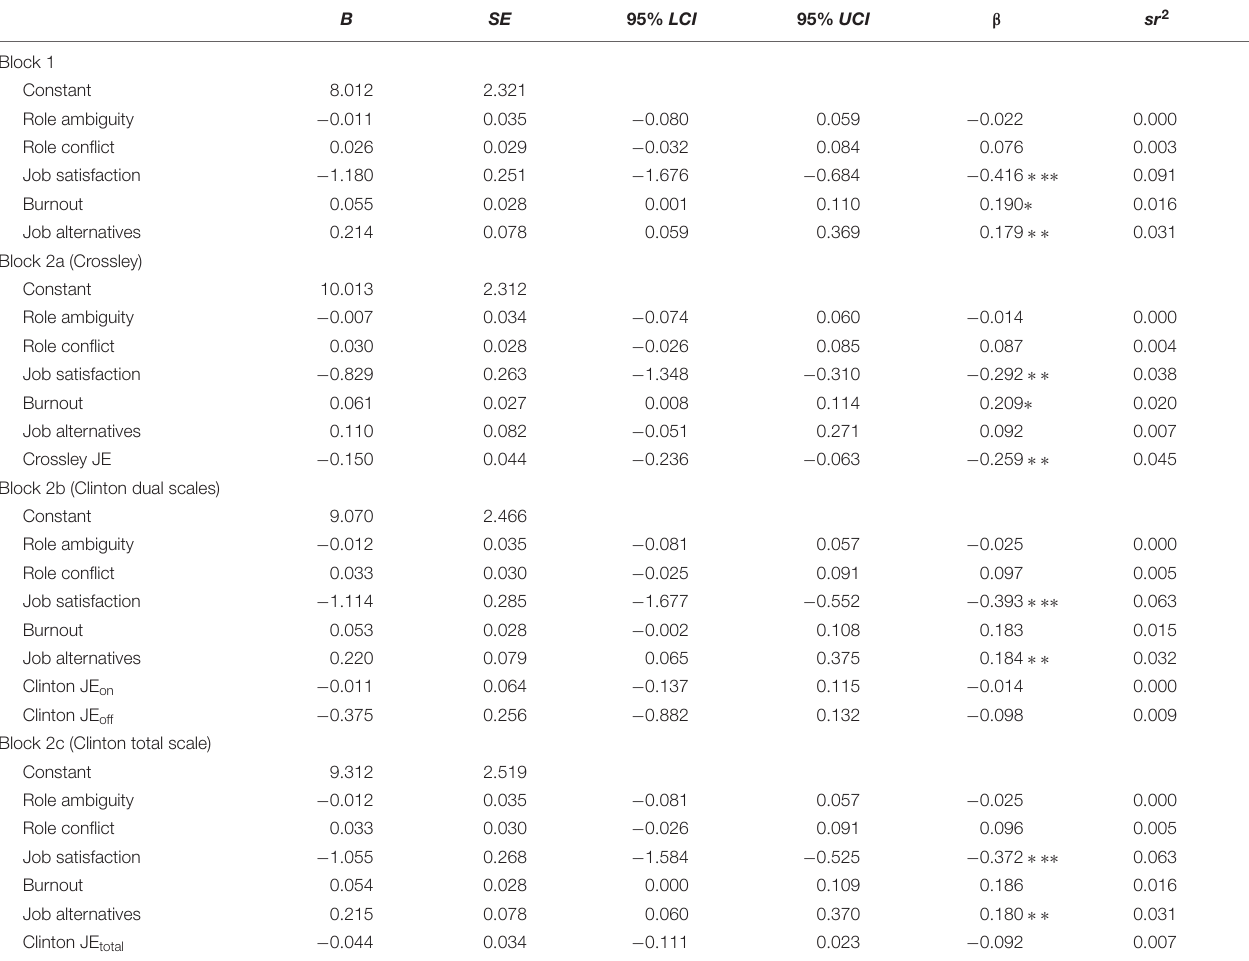
TABLE 4 | Predictor coefficients, significance, and confidence intervals of the models testing job embeddedness incremental validity for academic university staff ( N = 146). B SE 95% LCI 95%